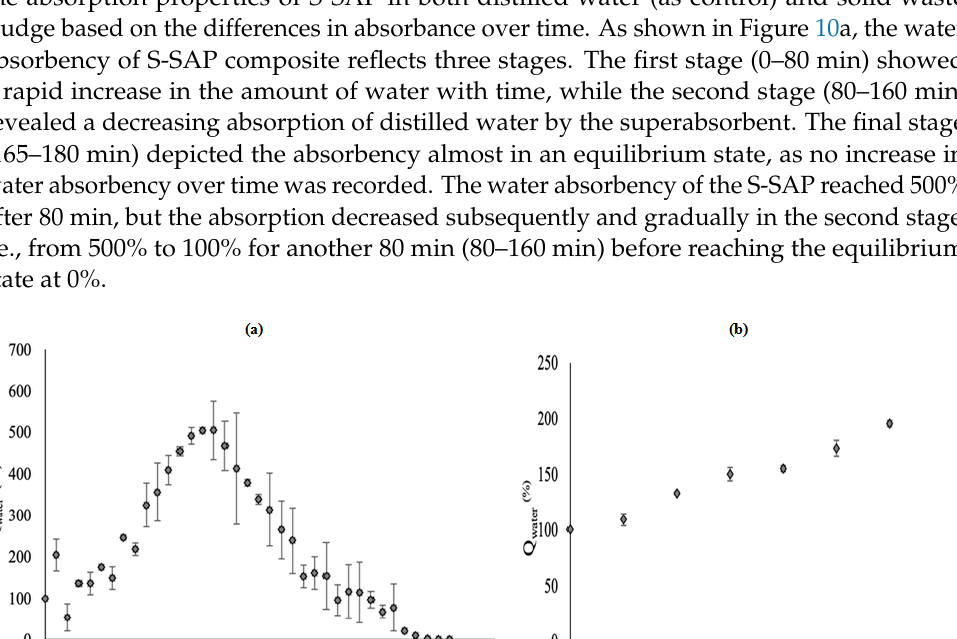
Figure 9. FTIR spectra of (a) methacrylic acid (b) starch (c) poly(methacrylic acid- co-sodium methacrylate) and (d) S-SAP.